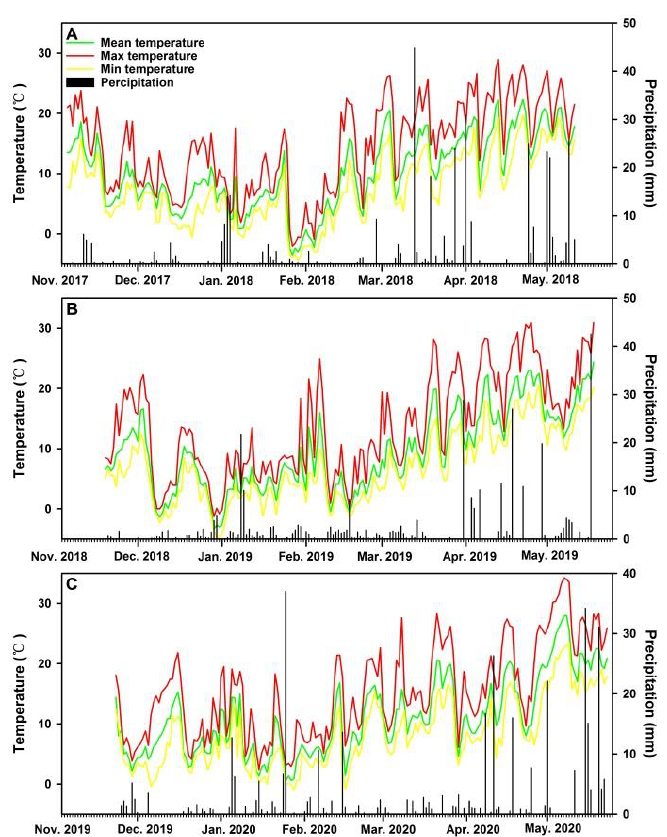
Figure 1. The daily mean, maximum and minimal temperature and daily precipitation during the